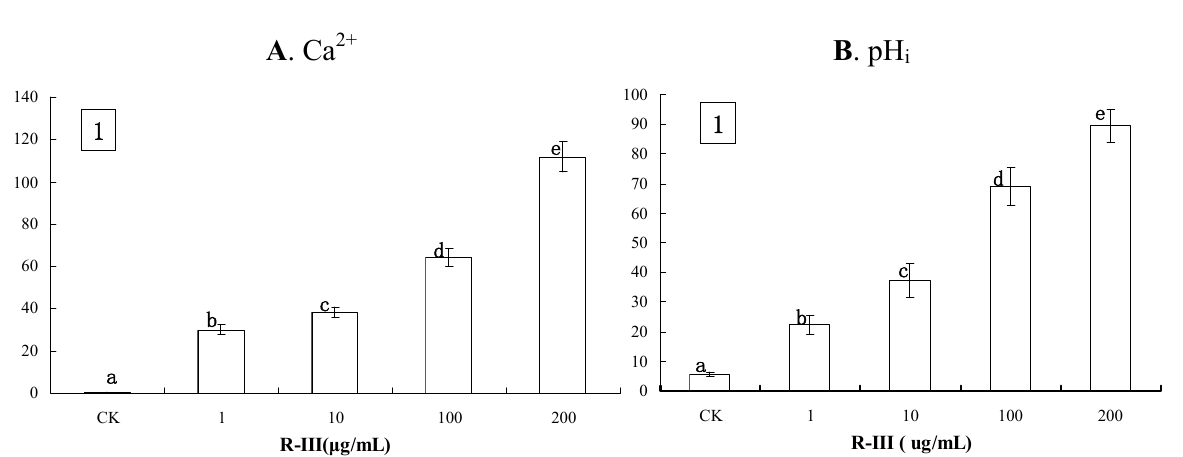
Figure 4. Effect of R- Ⅲ on [Ca 2+ ] and pH in Sf9 cells in presence of Hanks. ( A1 ). i i changes of [Ca 2+ ] in Sf9 cells stimulated by R-III at various concentrations as indicated by i in Sf9 cells relative change of Fluo-3AM fluorescence intensity; ( B1 ). Changes of pH i stimulated by R-III at various concentrations as indicated by relative change of Snarf1M fluorescence intensity; ( A a–d ). Dynamic changes of [Ca 2+ ] indicated by a dynamic trace i of Fluo-3AM fluorescence intensity in case of Sf9 cells treated with 0, 1, 100, 200 µg/mL of R- Ⅲ respectively; ( B a–d ). pH profile in cells subject to the protocol in ( A a–d ); ( A-e ). i Dynamic variation of [Ca 2+ ] in Sf9 cells treated with 100 µg/mL of R-III for two times; i profile in cells subject to the protocol in ( A-e ). Arrows indicated the addition of ( B-e ). pH i R- Ⅲ . Results of representative experiment derived from three repetitions and 4–6 cells were measured in each repetition. The error bars represent mean ± SEM for data derived from value of relative fluorescence intensity in each time interval. Treatment means sharing the same letter were not significantly different from each other ( P < 0 .